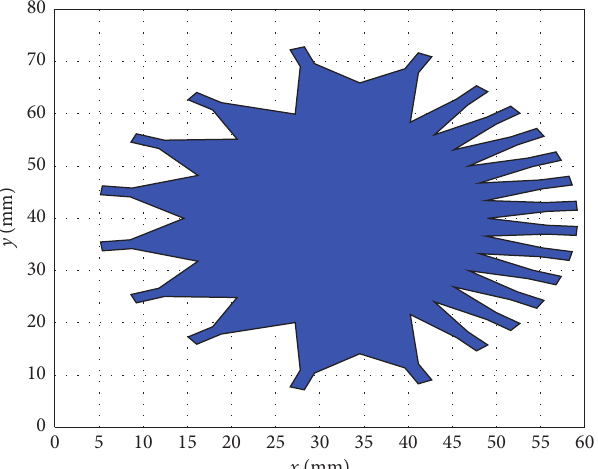
Figure 16: K-band Rotman lens geometry.